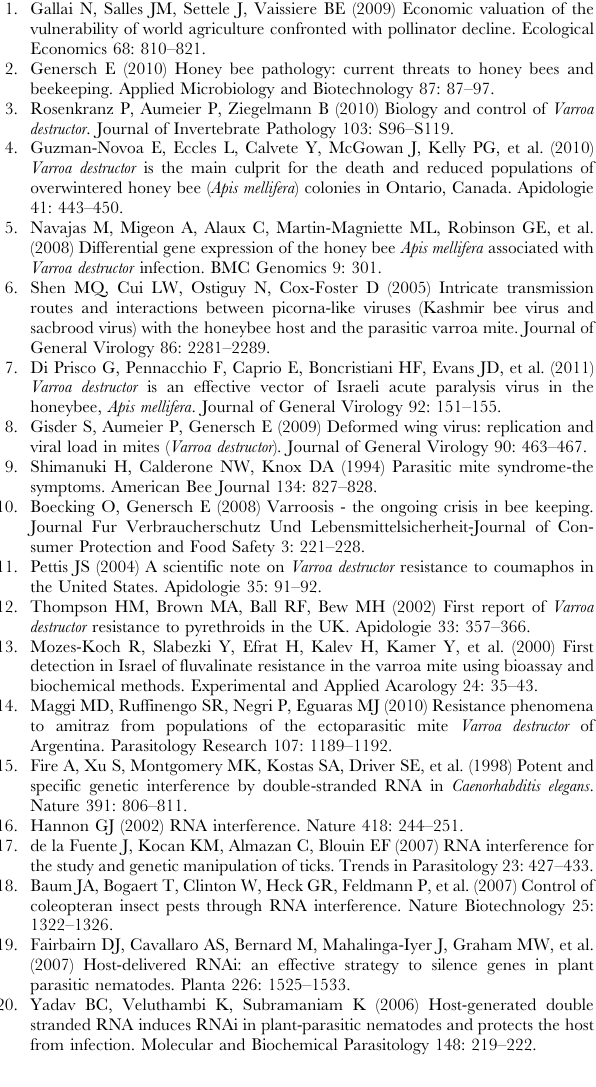
Table S3 List of primers for dsRNA preparation. Bold letters indicate sequences of T7 promoters. Amplicon sizes excluded T7 promoter sequences. * Designation of Varroa sequences as per Table S1.